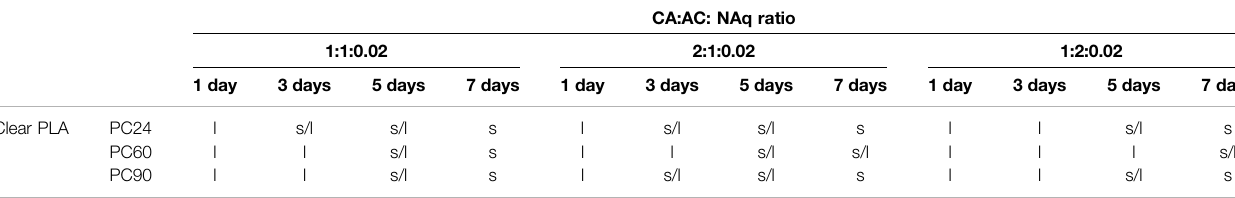
TABLE 4 | Longevity test of n-CA adhesives in clear